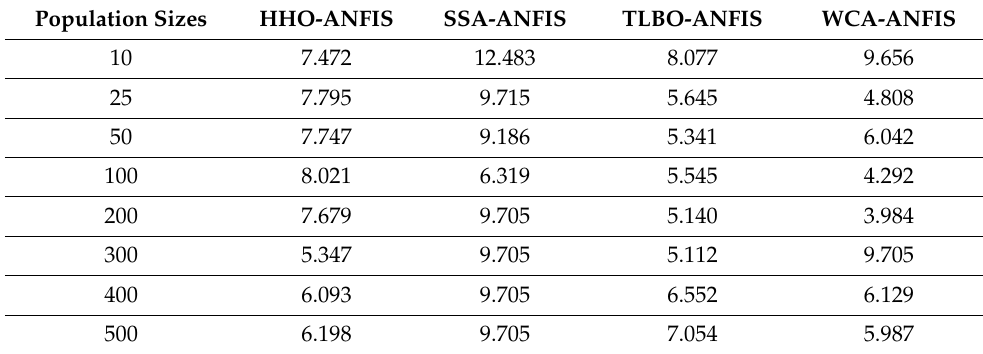
Table 3. The training RMSE of the tested swarm sizes. Population